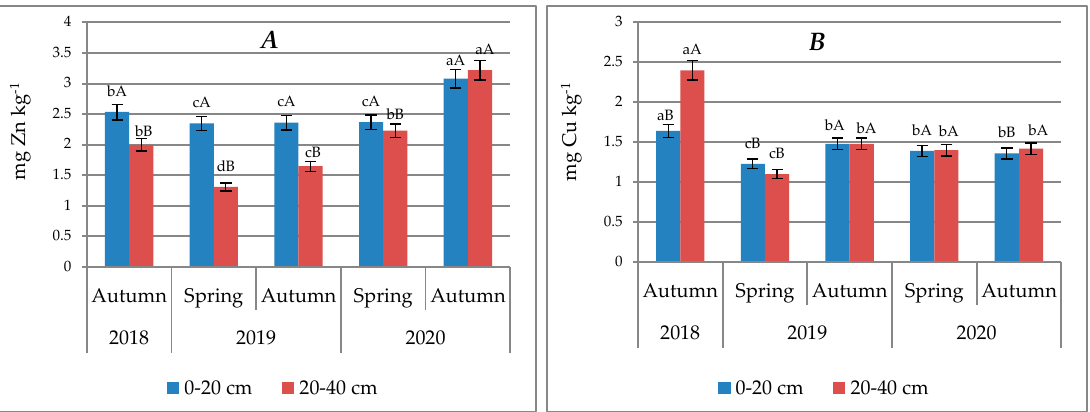
Figure 3. ( A , B ). Contents of available Cu ( A ) and Zn ( B ) in the studied soil. Different lower-case letters indicate significant differences among the soil sampling seasons (2018 autumn, 2019 and 2020 spring, autumn). Different upper-case letters indicate significant differences among the levels of sampling. Error bars represent standard deviation.